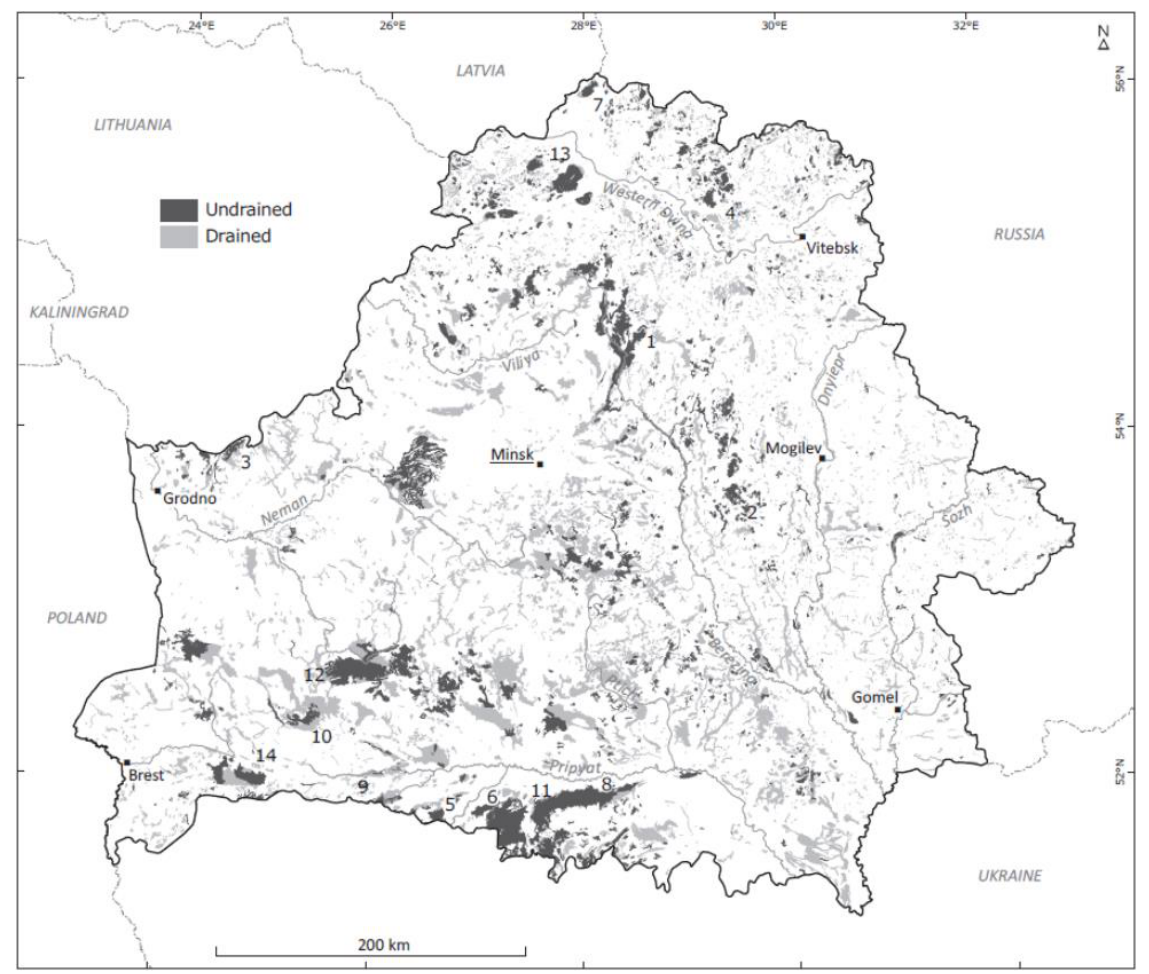
Figure 1. The current distribution of natural mires and drained peatlands in Belarus. Source: SPCB (2016). This Figure is reproduced from Bambalov et al .